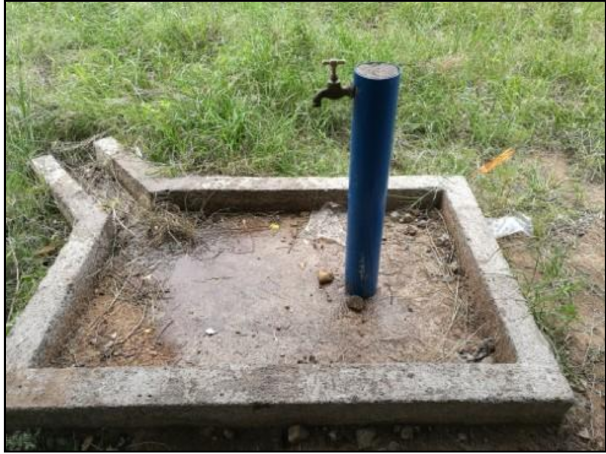
Figure 3. A communal tap outside the